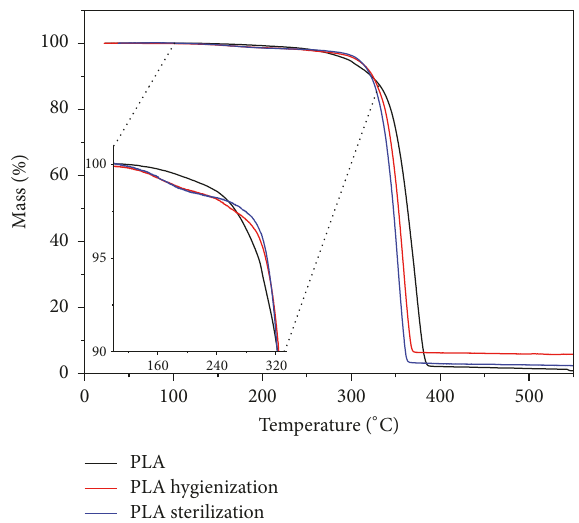
Figure 5: TGA thermogram of the PLA before and after the hygienization and sterilization process.